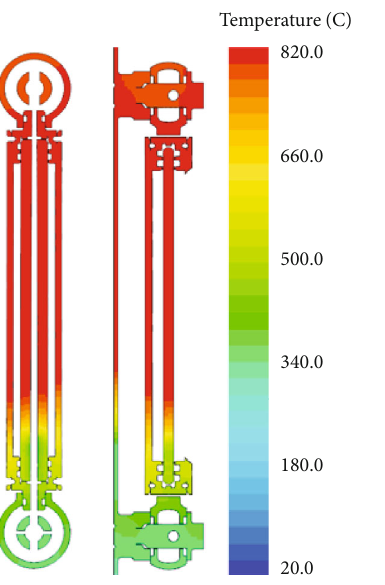
Figure 6: Temperature of the gauge glass at t = 5 minutes.